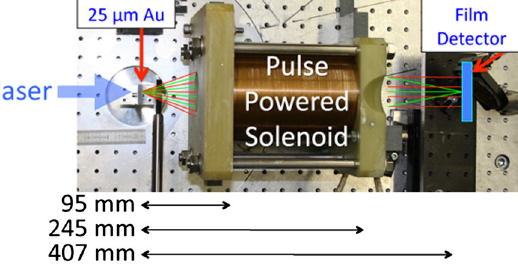
brightening.FIG. 4. Experimental setup: The windings of the solenoid begin 95 mm from the target. Laser-target alignment optics and dosimetric film are positioned under vacuum using motor